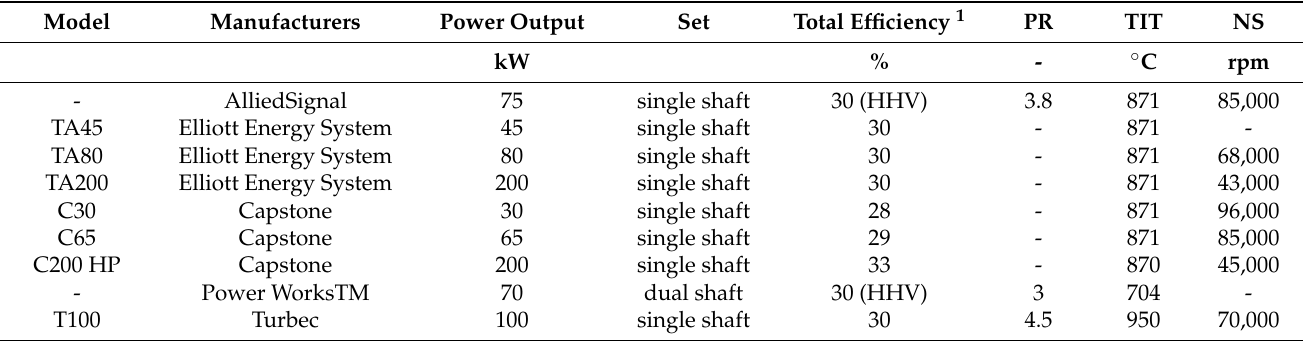
Table 5. Technical characteristics of leading microturbine manufacturers